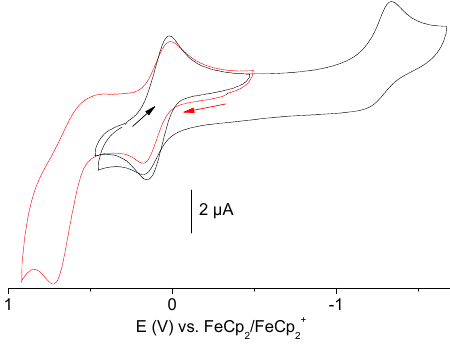
/ n Bu µ -Cl) 2 )Cl} 2 ( 2 ] in MeCN 4 NPF 6